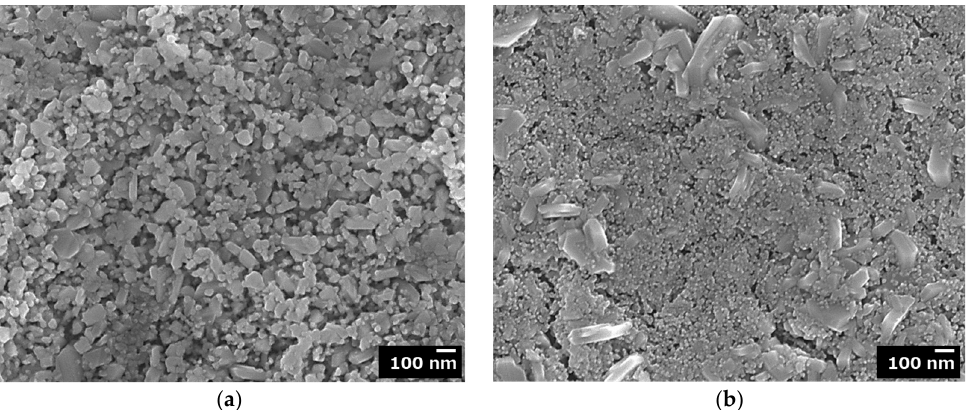
Figure 4. Field electron scanning electron microscope (FE-SEM) images showing surface morphologies of ( a ) F spray and ( b ) F ss .